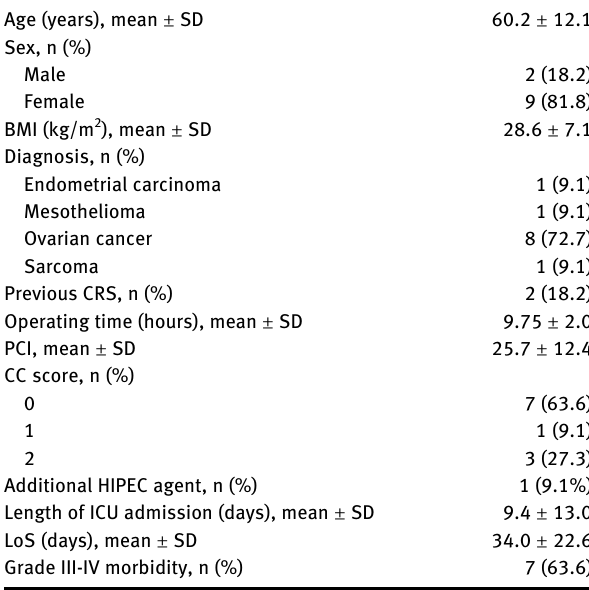
Table  : Patient demographics and clinical characteristics (n= 